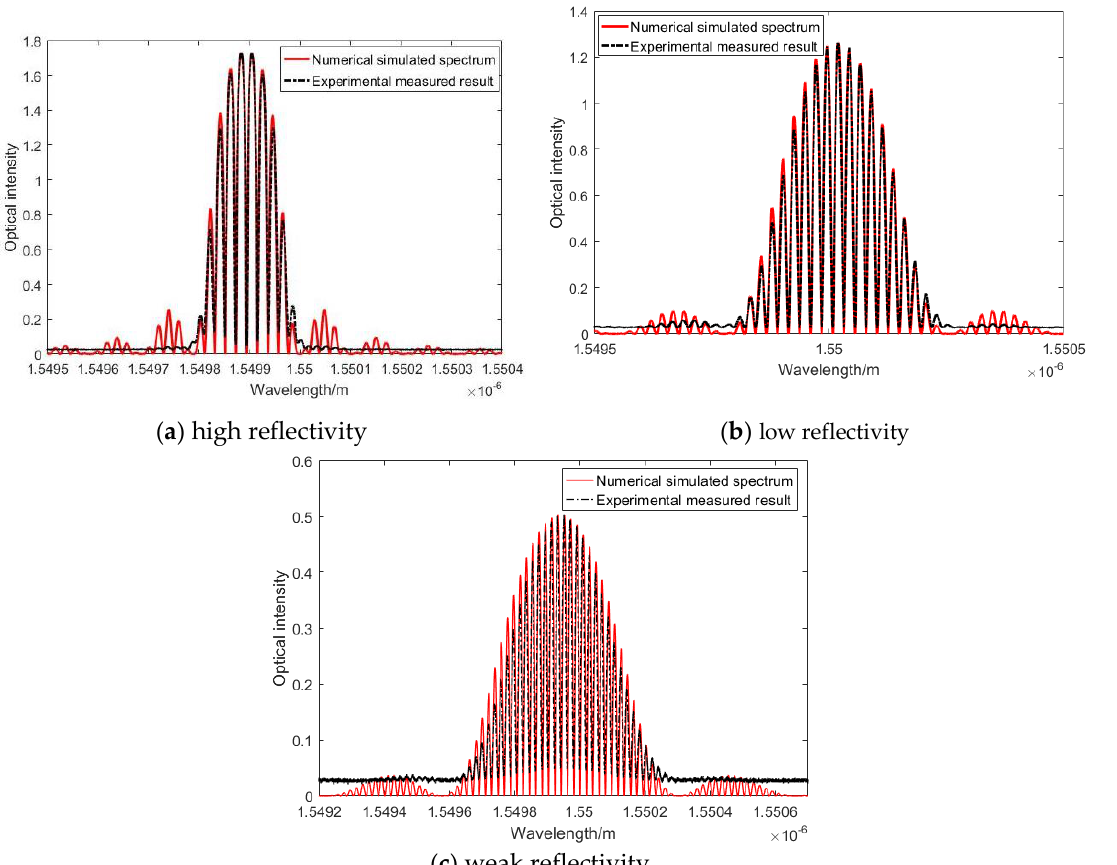
Figure 8. Comparison between simulated and measured FBG-based FP sensor ’ s spectrum. Table 2. FBG-based FP sensor parameters.